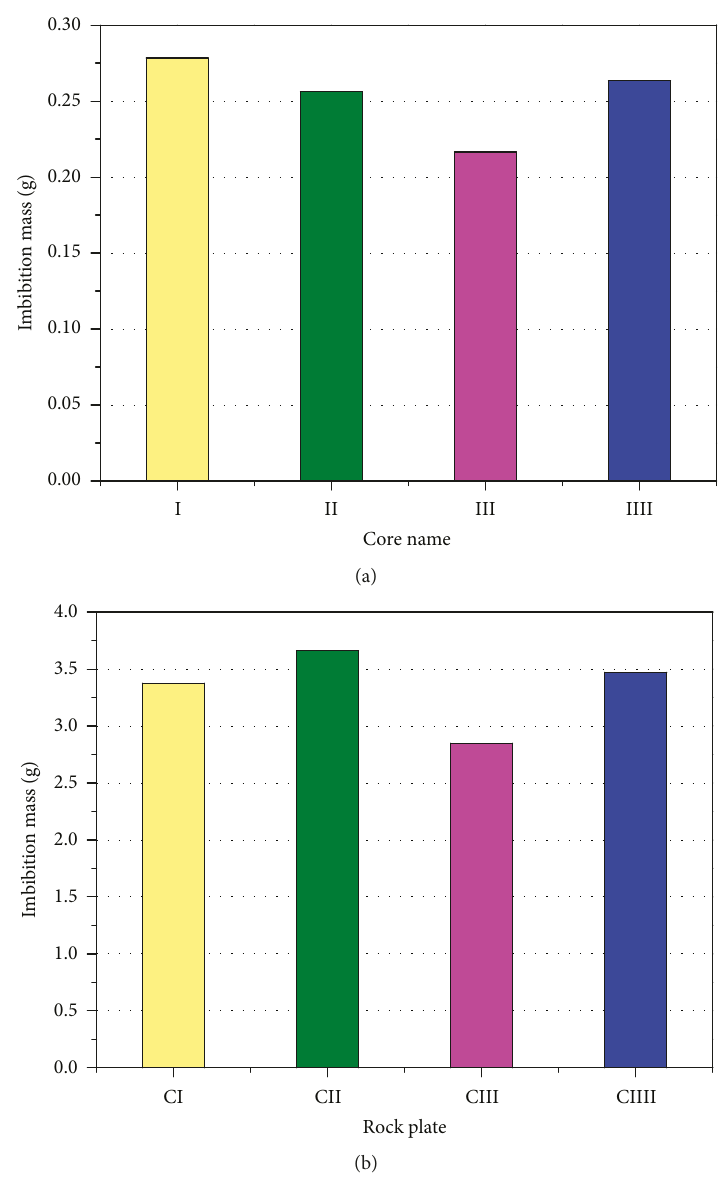
Figure 14: Single-sided imbibition: (a) standard rock imbibition and (b) test sample